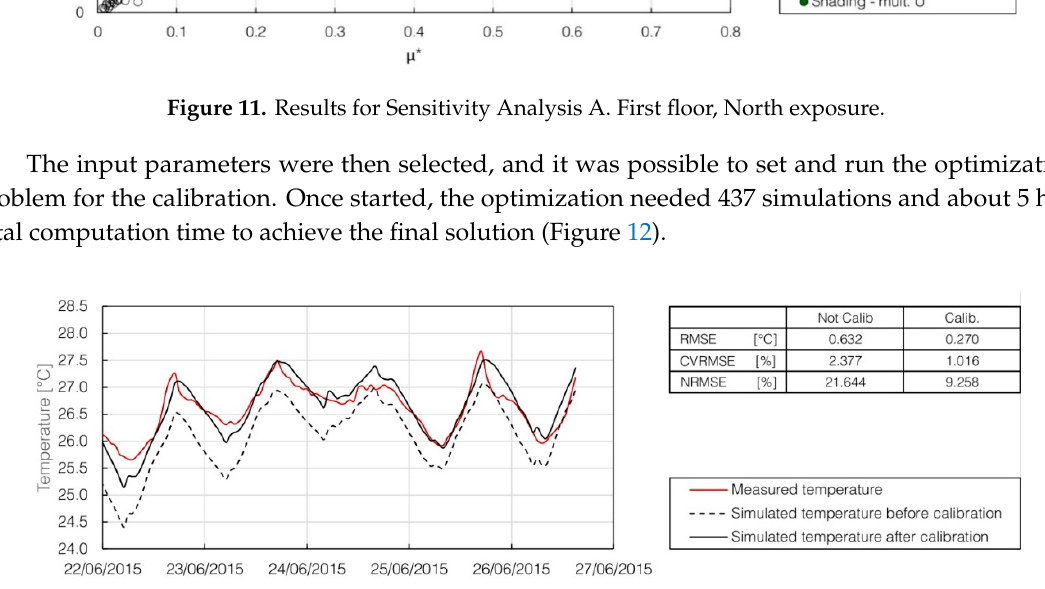
Figure 12. Results for Calibration A. First floor, North exposure.